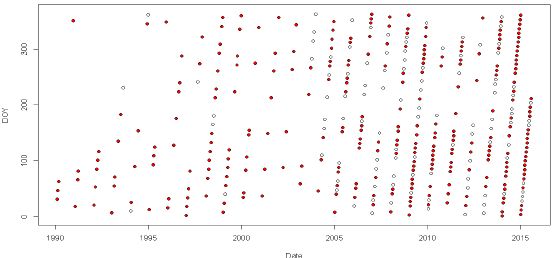
Figure 2. Distribution of Landsat scenes over temporal scale. cover